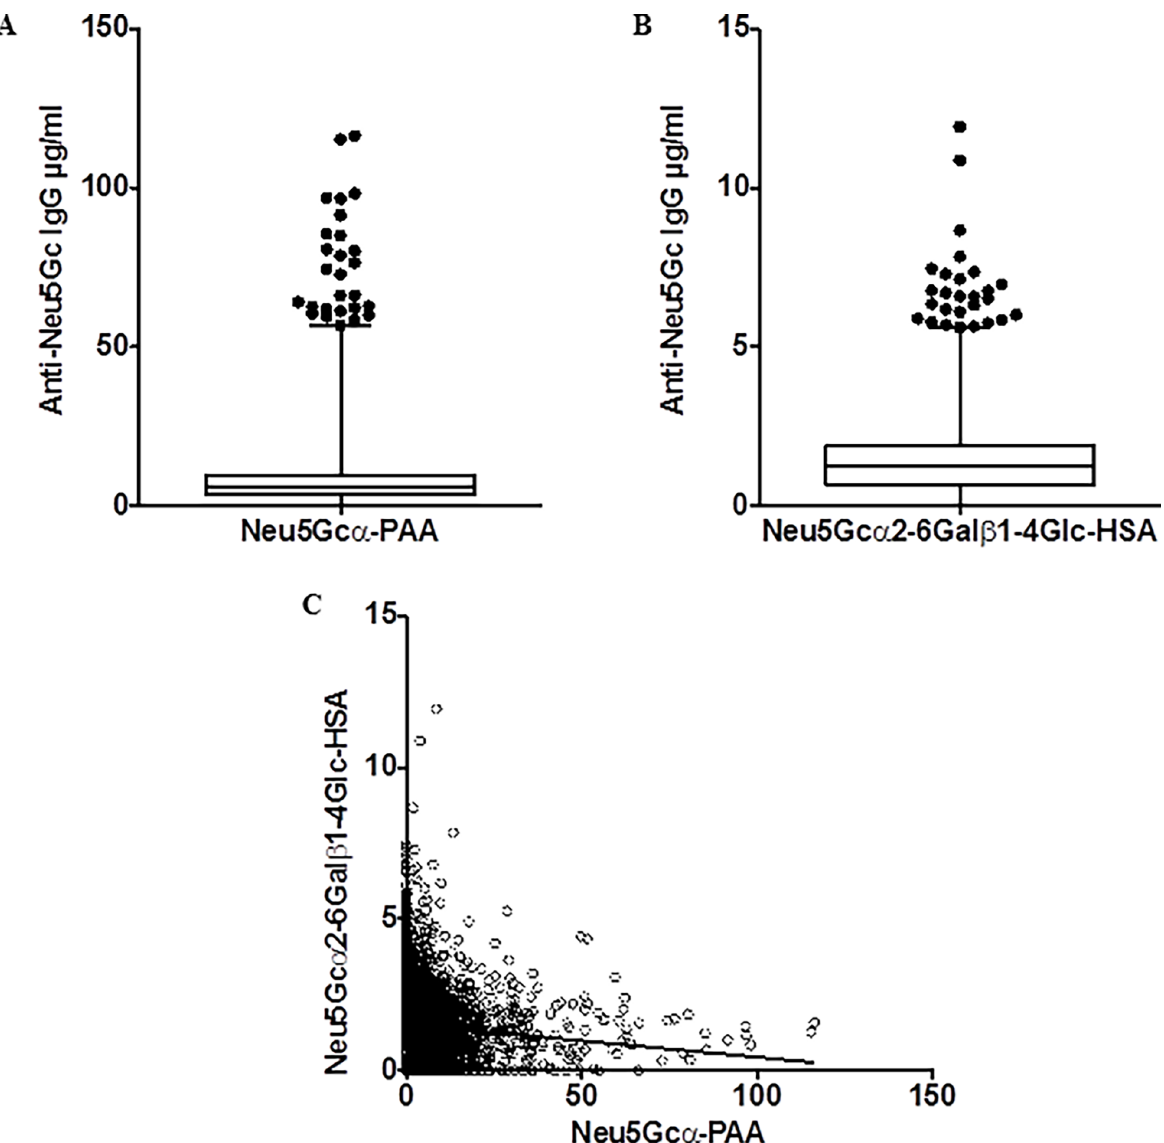
Fig 1. Distribution of Anti-Neu5Gc IgG titers in EPIC-Norfolk cohort using defined ELISA target antigens. Each dot represents a value for a single subject. (A) Levels of serum anti-Neu5Gc IgG quantified by ELISA using Neu5Gc α 2-polyacrylamide (Neu5Gc α 2-PAA) as the target antigen (N = 2716). The mean anti-Neu5Gc IgG titer was 8.6 μg/ml (SD±10.6). (B) Levels of serum anti-Neu5Gc IgG quantified by ELISA using Neu5Gc α 2–6Lac β -human serum albumin (HSA) as the target antigen (N = 2712). The mean anti-Neu5Gc IgG titer was 1.4 μg/ml (SD±1.2). (C) There was no correlation between anti-Neu5Gc IgG antibody levels directed against the two different chemically synthesized ELISA targets: Neu5Gc α 2-PAA and Neu5Gc α 2–6Lac β -HSA.